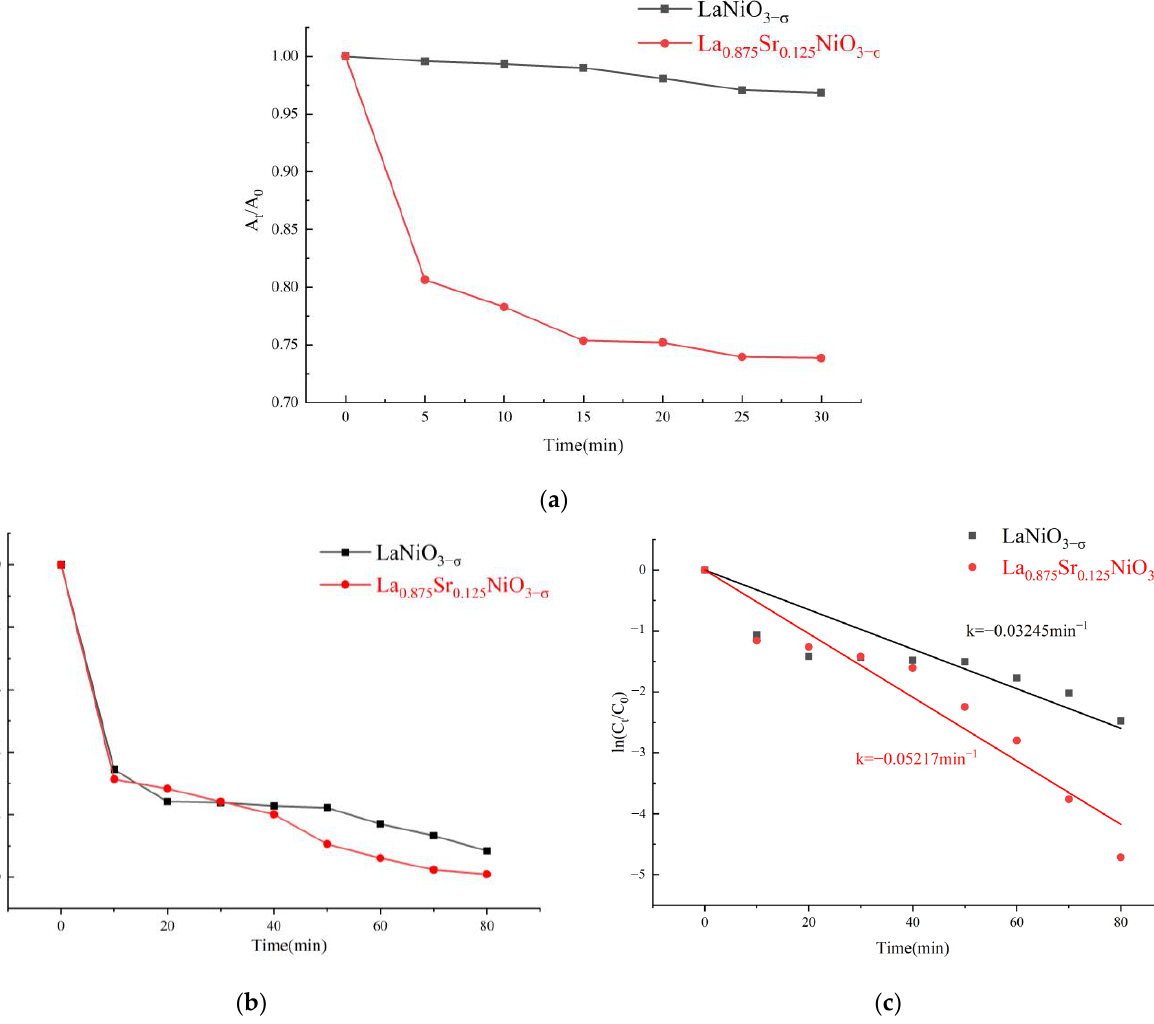
Figure 7. Adsorption curves ( a ) under a dark environment; degradation curves ( b ) and kinetic curves ( c ) of MO catalyzed by undoped and Sr-doped LaNiO 3−σ under the simulated solar irradia- tion.